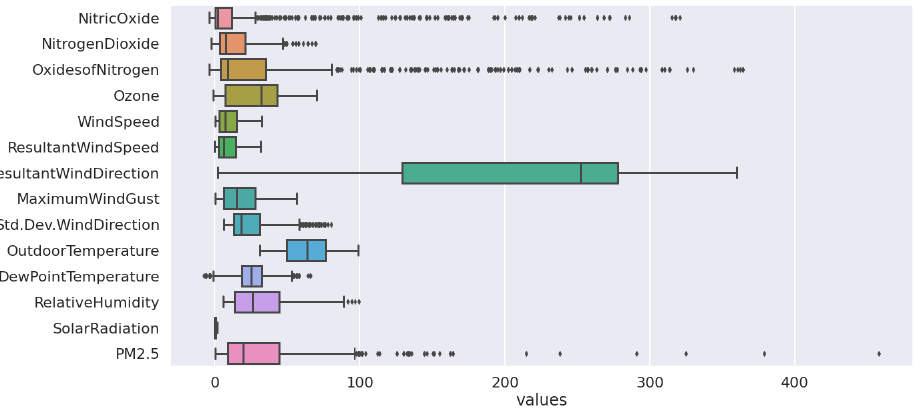
Figure 4. Box and whisker plot of all